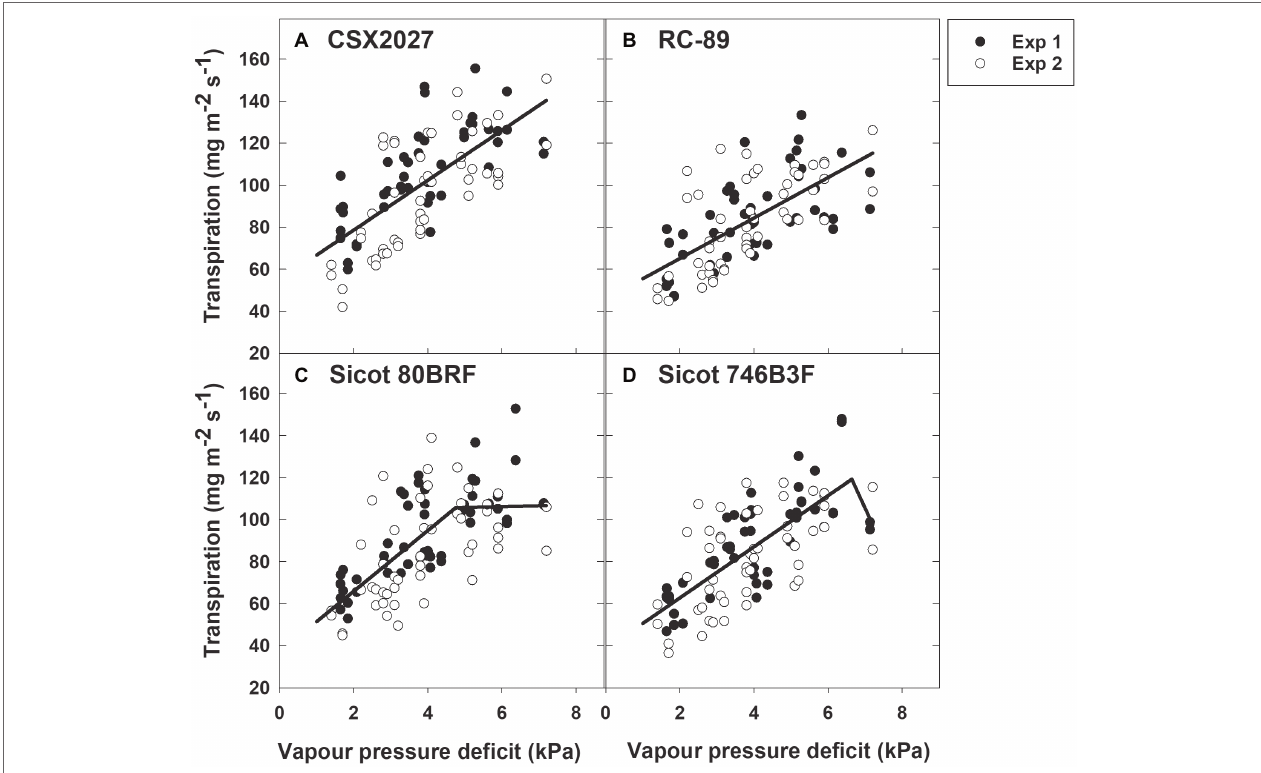
FIGURE 1 | Transpiration response of four cotton genotypes to vapour pressure deficit (VPD); (A) CSX2027, (B) RC-89, (C) Sicot 80BRF, and (D) Sicot 746B3F. Data from experiment 1 (Exp 1) is shown by black symbols and experiment 2 (Exp 2) shown by white symbols. Regression lines are shown by the black solid